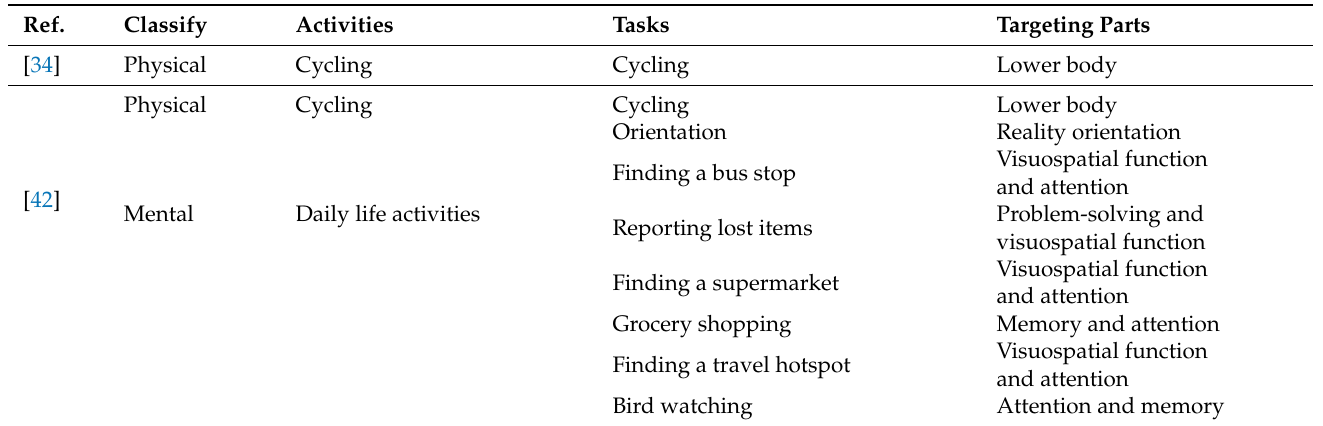
Table 1. Activities and game tasks in VR exercise games for the elderly.